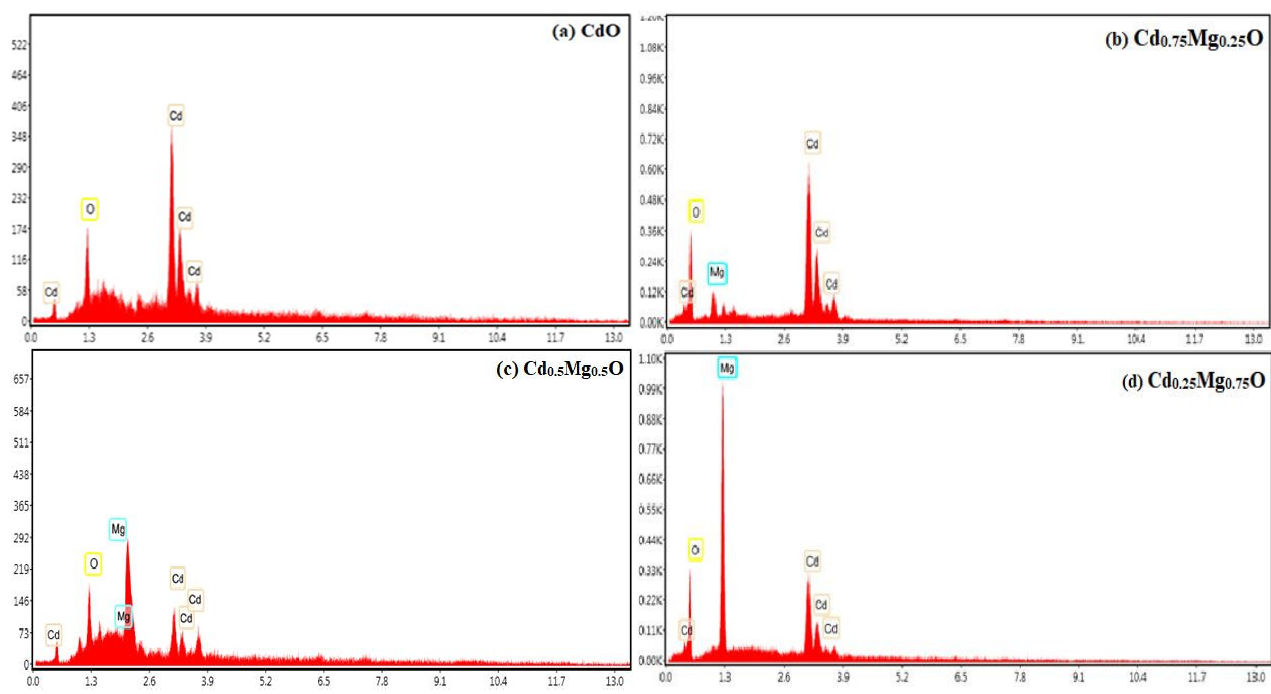
Figure 4. EDX spectra of ( a ) CdO; ( b )Cd 0.75 Mg 0.25 O; ( c ) Cd 0.5 Mg 0.5 O; ( d ) Cd 0.25 Mg 0.75 O. Table 2. Elemental composition of vacuum-annealed CdO, Cd 1−x Mg x O, and MgO films (EDAX). Table 2. Elemental composition of vacuum-annealed CdO, Cd 1 − x Mg x O, and MgO films (EDAX).